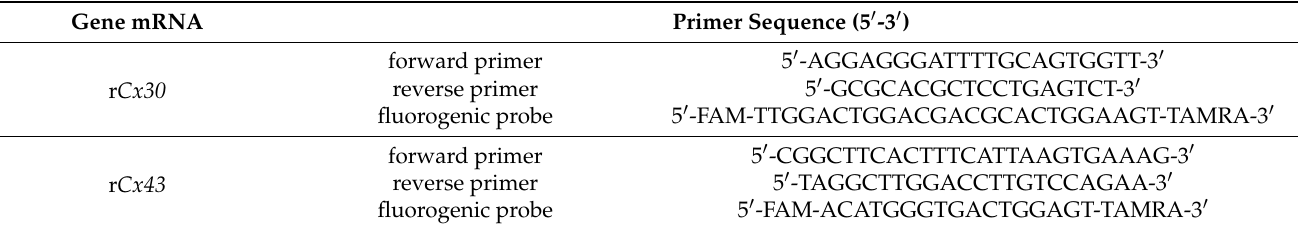
Table 3. PCR primers used in the gene expression